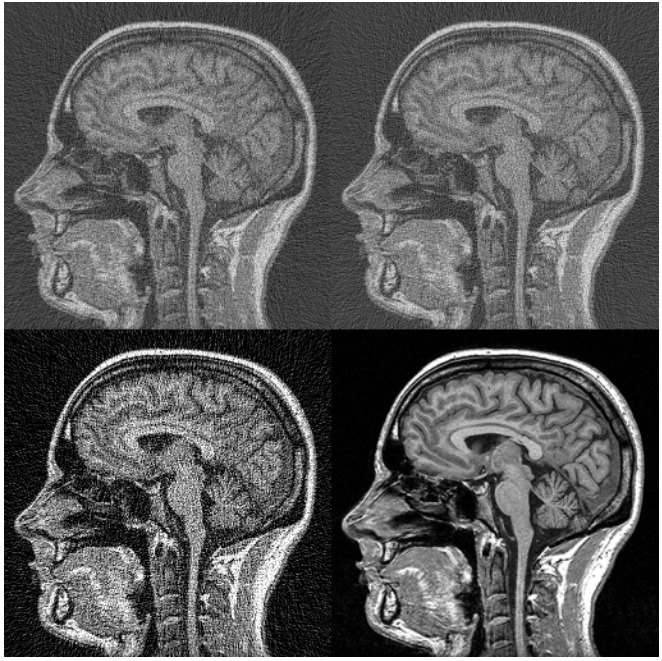
Figure 15. Images recovered after applying gaussian distributed noise of 5% of the magnitude of transformed coefficients. From top to bottom , and left to right : Press’ method, ours, Shkolnisky’s, original